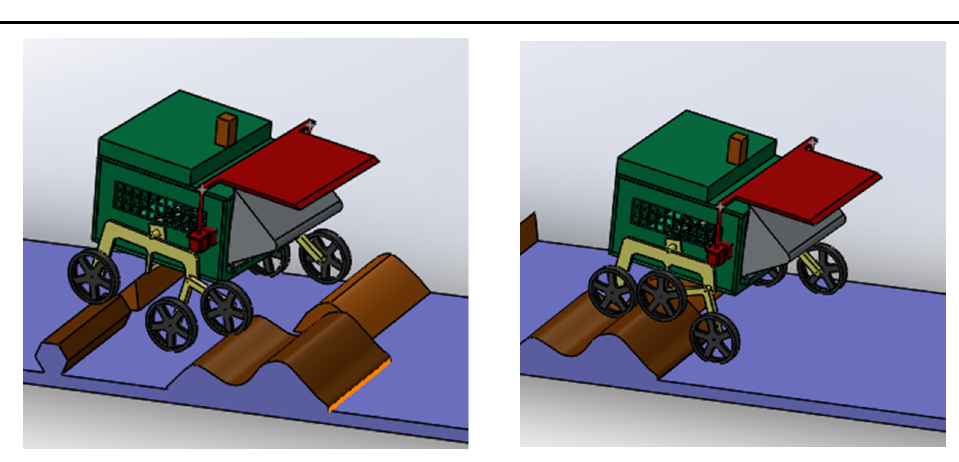
Figure 5. Loss and mAP in the Custom Mask-RCNN model.